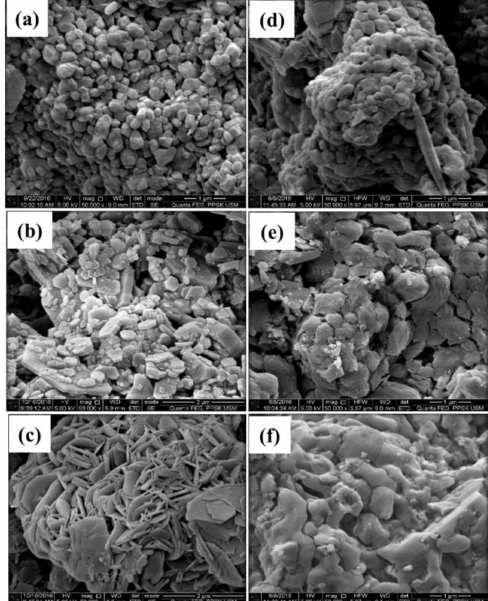
Figure 5. FESEM images of CaCO 3 prepared in ( a , d ) ethanol; ( b , e ) methanol; and ( c , f ) propanol after freeze drying ( left ) and oven drying ( right